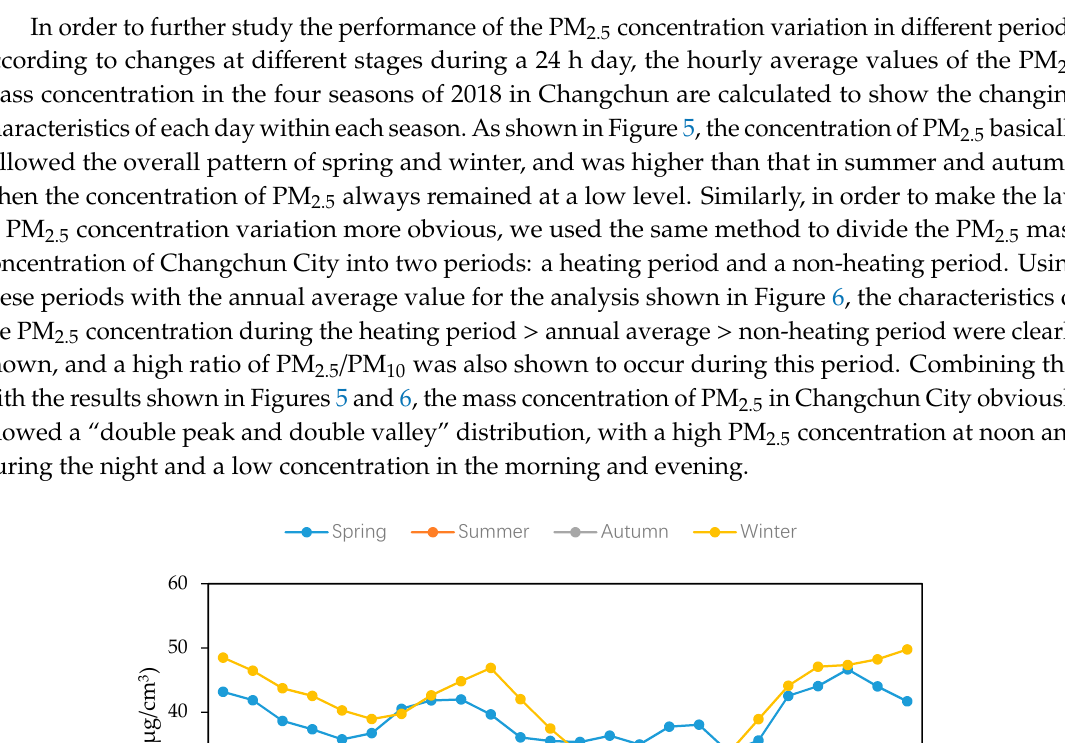
Figure 6. Variation in the PM 2.5 concentration in the heating period and non-heating period in Changchun City in 2018. 3.2. Cluster Analysis As shown in Figure 7, a total of 8760 meteorological trajectories at a height of 500 m in Changchun during the whole year of 2018 were divided into 8 average trajectories according to the source and orientation of the airflow using the stepwise clustering analysis program. The point where the trajectories gathered is Changchun. The columnar diagram on the different average trajectories shows the quantity of trajectories occupied in different months. We numbered the clustering results as cluster 1–8. Specific information on the seasonal proportion of each cluster is shown in Table 2.